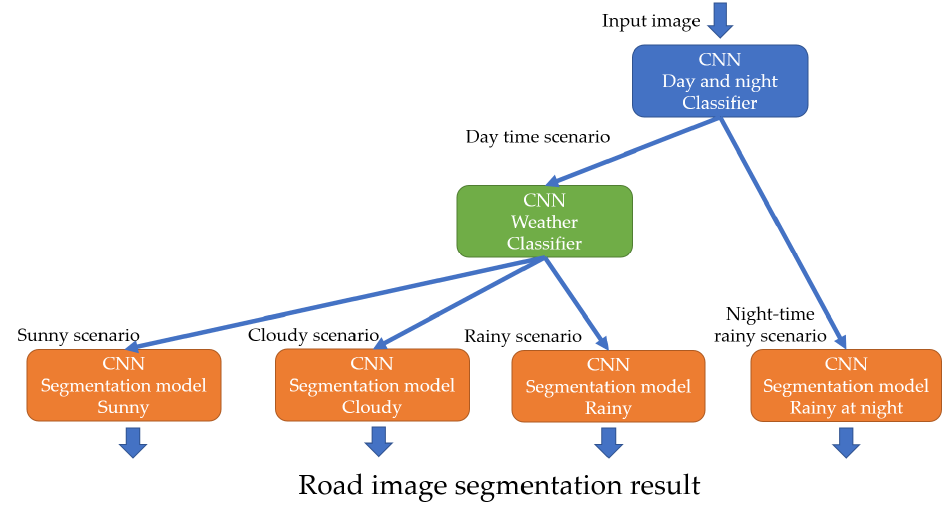
Figure 7. Topology of the model ‐ switching architecture.